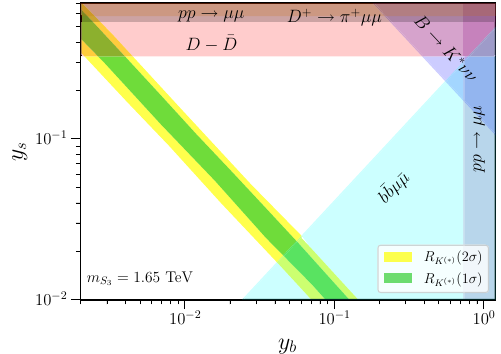
Fig. 1 1 σ (green) and 2 σ (yellow) allowed range for R K ( ∗ ) while accounting for BR ( B s → μμ) in the relevant Yukawa coupling plane, with S 3 LQ mass fixed at 1.3TeV. Cyan and vertical purple shaded regions are exclusion limits obtained from LQ pair production in pp → b ¯ b μ ¯ μ [81] and most recent LHC searches in the high- p T bins √ s = 13TeV with 140fb − 1 [82,83]. The blue, red, of pp → μμ at and black regions correspond to the exclusion from B → K ∗ νν [84], D − ¯ D mixing [85,86], and D + → π + μμ decay